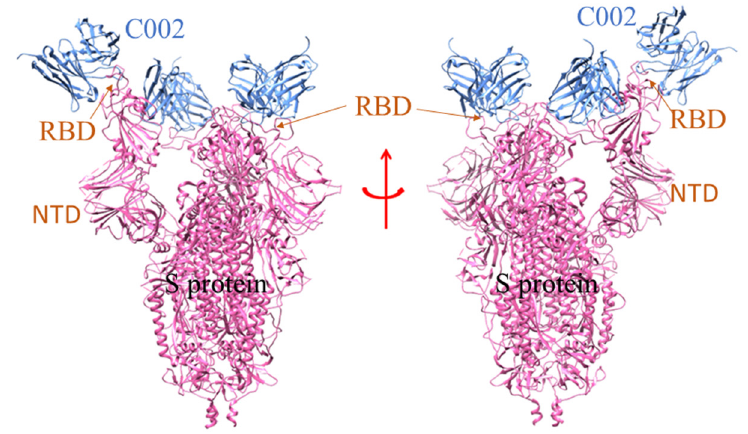
Figure 5. The structure shows the SARS ‐ CoV ‐ 2 S 6P trimer in a complex with human nAb (C002) Fab fragment [PDB id: 7K8T]. The nAb (C002) Fab fragment partially interacts with the RBD and NTD regions of the S ‐ protein of SARS ‐ CoV ‐